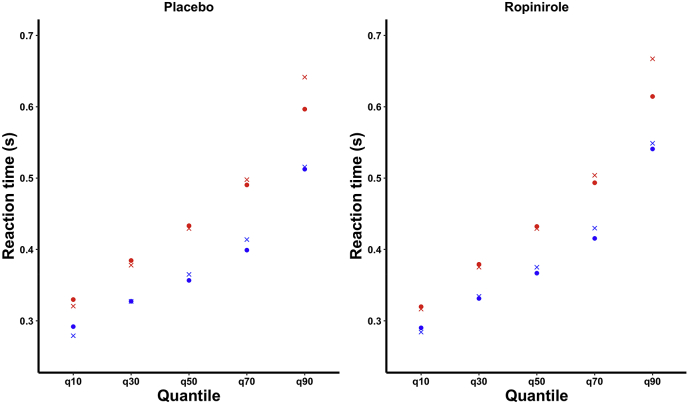
Real and HDDM-predicted reaction times.Plots show critical (red) and non-critical (blue) reaction times organised by quantile, for each drug condition. Circles represent real data points whereas crosses represent simulated data points. Reaction times are simulated using the HDDM model with the lowest DIC value. . (For interpretation of the references to colour in this figure legend, the reader is referred to the Web version of this article.)